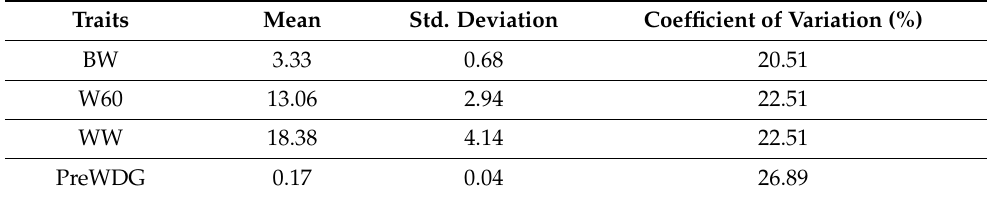
Table 1. Descriptive statistics of the growth traits of Turkish Saanen kids.